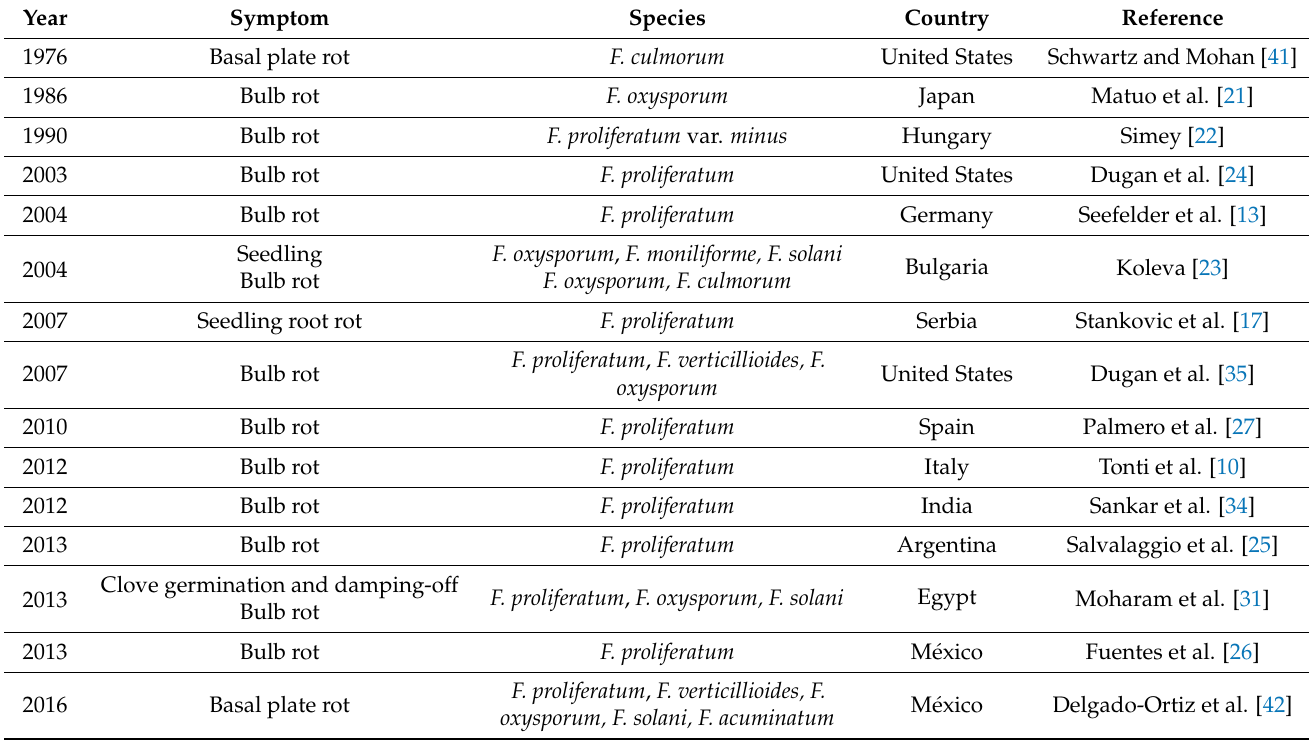
Table 1. Symptoms and Fusarium spp. associated with dry rot disease of garlic